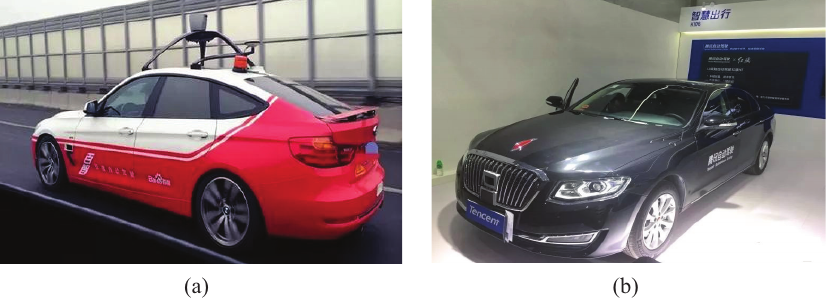
Figure 2. Self-driving cars of the companies in China: ( a ) Baidu’s self-driving car; ( b ) Tencent’s self-driving car.